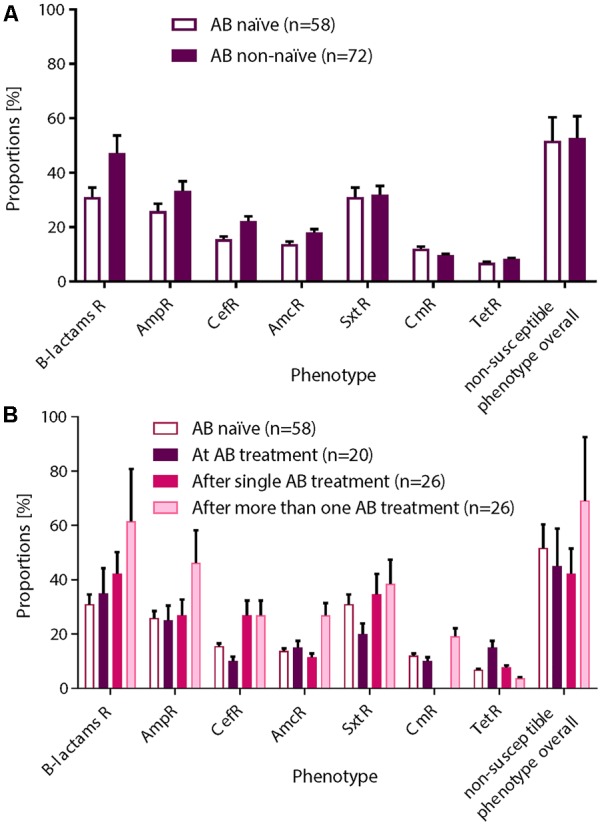
Non-susceptible phenotypes were not associated with AB treatment history. After functional metagenomics analysis of all samples (n = 130), proportions of non-susceptible phenotypes observed for all AB tested were calculated according to the AB status of the patient: (A) AB naïve vs. non-naïve or (B) AB naïve (group 0), collected during an AB treatment (group 1), collected after a single AB treatment (group 2), or collected after more than one AB therapy (group 3). A χ2 test for a 2 × 2 or 2 × 4 contingency tables was applied for statistical significance. (A) Non-susceptible phenotypes were more frequently recovered from patient with AB history. (B) We observed an increasing trend for β-lactams resistance in patients who received one or more AB therapies. Standard deviations are indicated.